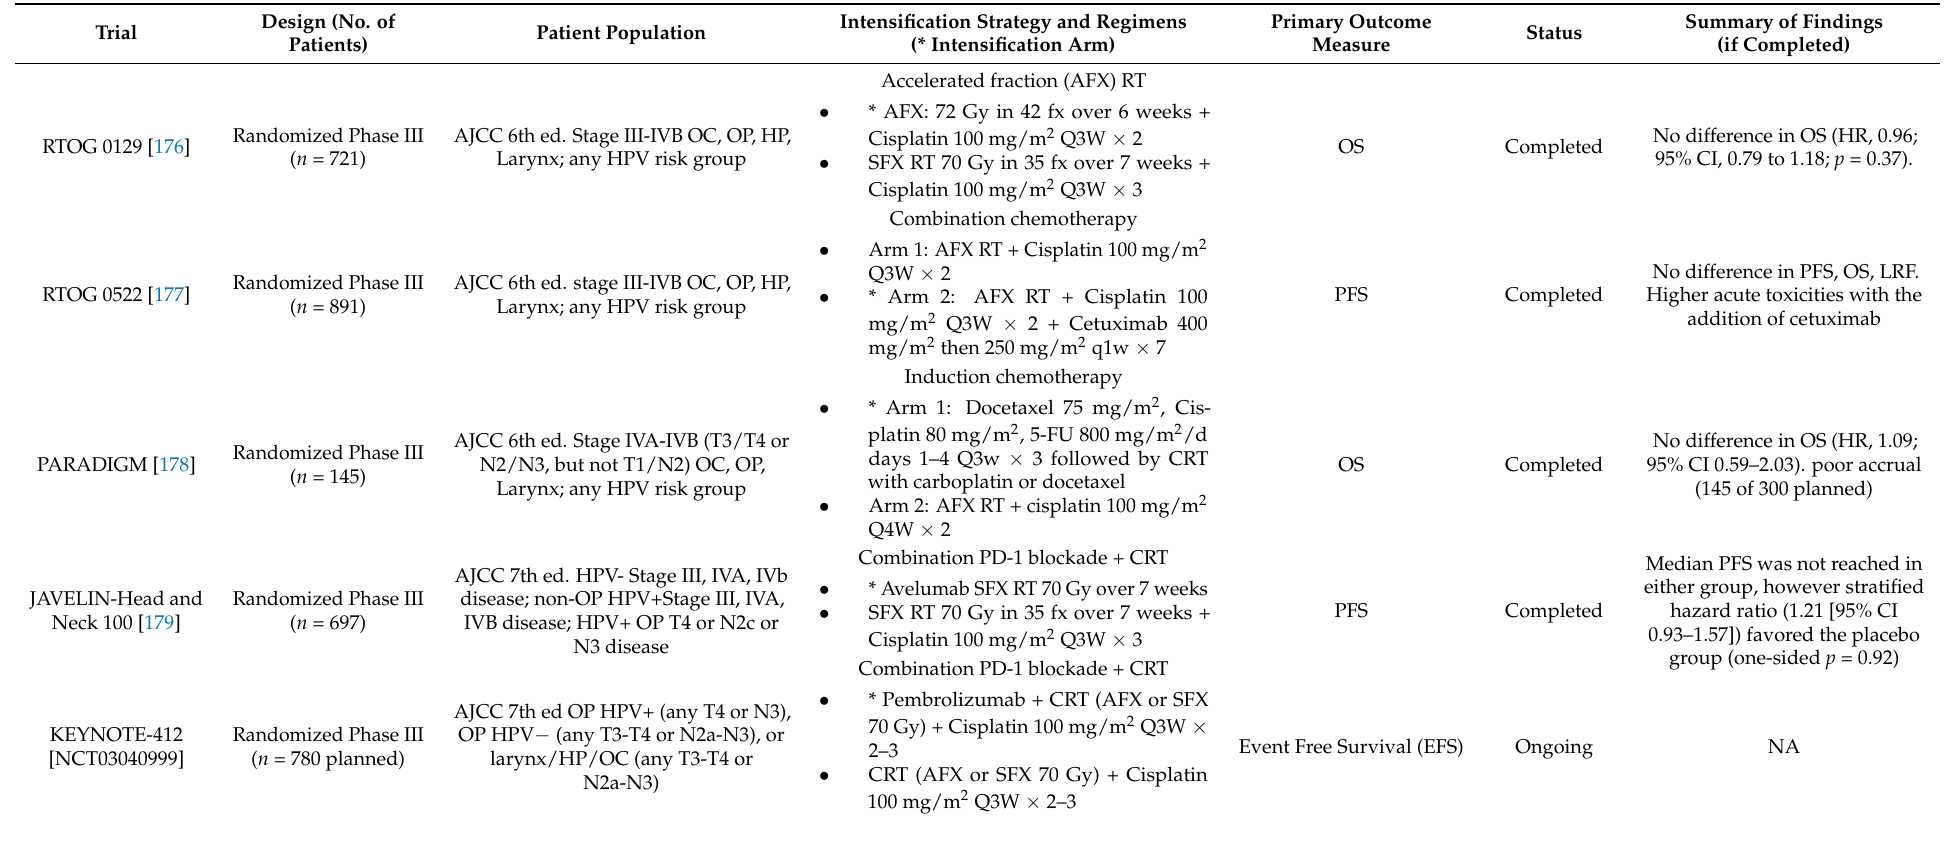
Table 4. Selected treatment intensification